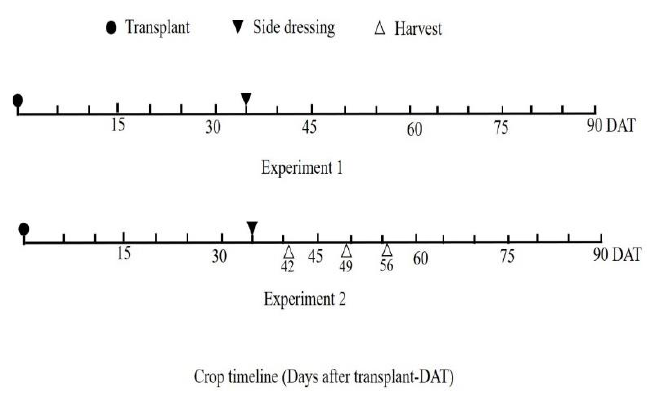
Figure 2 . Timelines of experimental activities over the 90 DAT for experiment 1 and 2 Rape leaf biometric